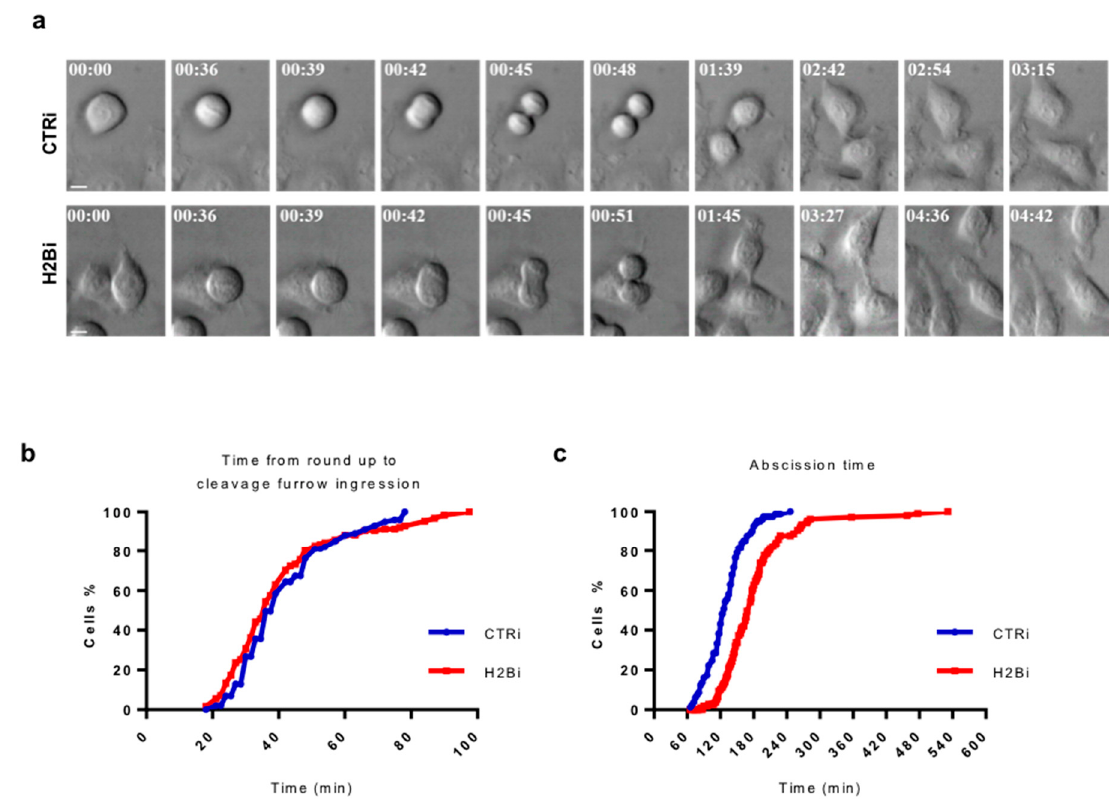
Figure 4. H2B depletion is associated with abscission delay. CTRi and H2Bi HeLa cells were obtained as above and were followed through division by time-lapse microscopy. ( a ) Representative stills from time-lapse recording of HeLa CTRi and H2Bi cells. The time (in hrs:min) since the beginning of the round up is shown. Scale bar is 10 µ m. The relative videos are Videos S1 and S2. CTRi cells divide and return mononucleated in about 3 h while H2Bi cells remain connected by intercellular bridge for several hours before abscission occurs. ( b ) The time from round up to cleavage furrow ingression was determined in CTRi HeLa cells ( n = 150) and in H2Bi ( n = 100). ( c ) The time from cleavage furrow ingression to abscission (abscission time) was determined in CTRi HeLa cells ( n = 81) and in H2Bi ( n = 107). In ( b ) and ( c ), the cumulative percentage of the analyzed cells from four independent transfections is plotted as function of